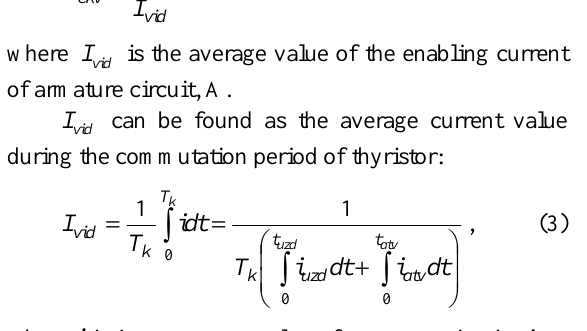
Fig 7. A circuit diagram of thyristor used for pulse regulation of braking rheostat resistor: VS2, C k , L k , D m , R m , D k – elements of forced thyristor VS1 commutation;